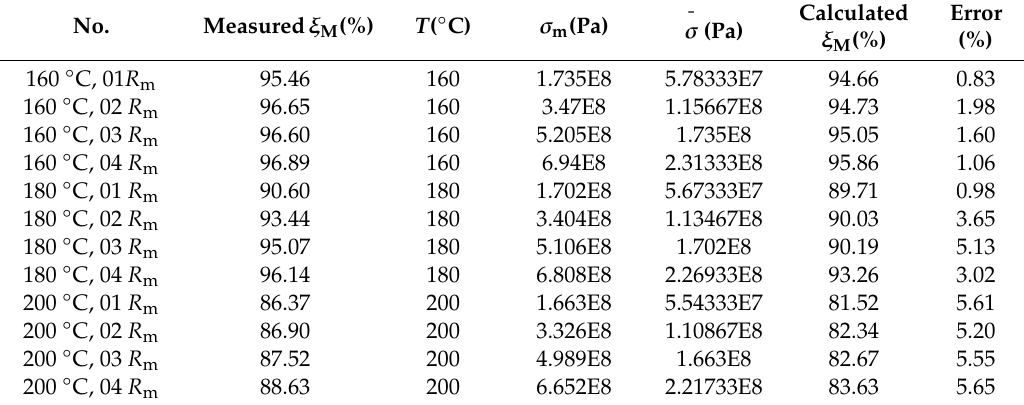
Table 1. Parameters used for building martensite phase transformation model.